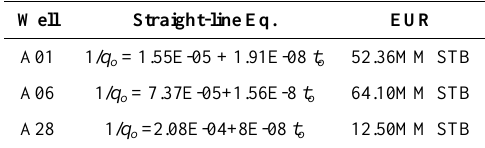
Table 3. EUR from reciprocal of oil rate versus oil material balance time